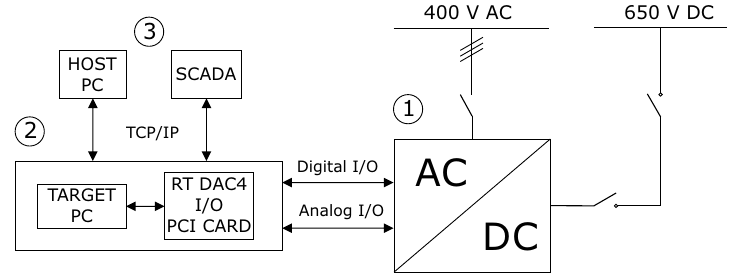
Figure 6. Block diagram of the PHIL system, including: (1) DC/AC bidirectional converter— Functional unit (FU), (2) Functional Unit Controller (FUC) and (3) Communication and control peripherals.